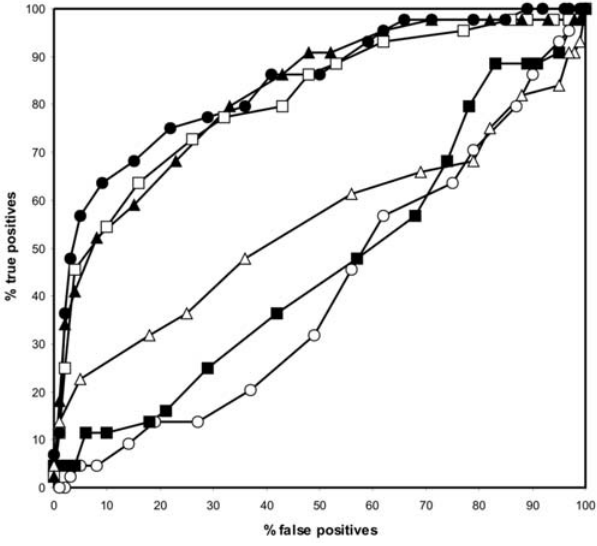
Figure 3. ROC curves as calculated from the PSSMs of different DnaK-substrate structures. The curves represent structures 1DKX (closed circle), 1DKY A (open square), 1DKY B (closed triangle) and 3 NMR structures from the same ensemble (open triangle, open circle,